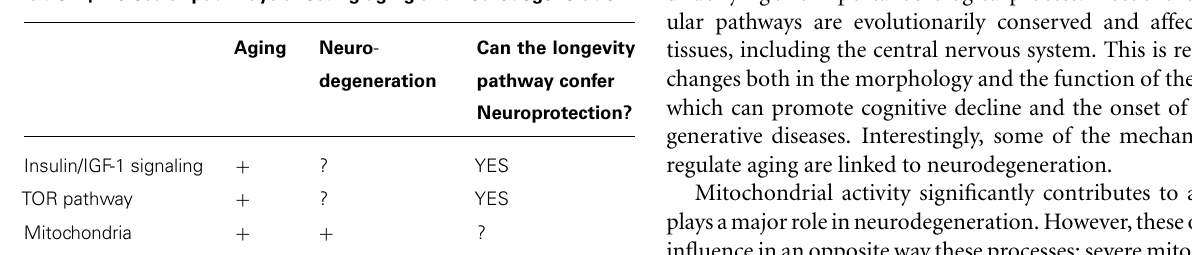
Table 1 | Molecular pathways affecting aging and